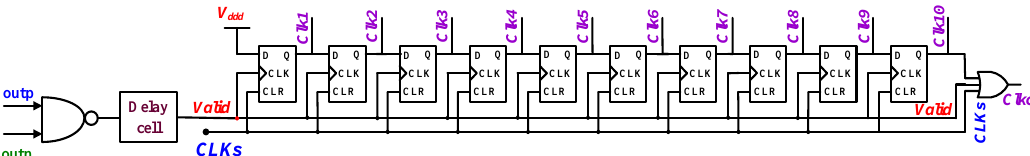
Figure 10. Schematic of the modified asynchronous SAR control logic circuit. Table 1. State table of SAR control logic for controlling the DAC switches.